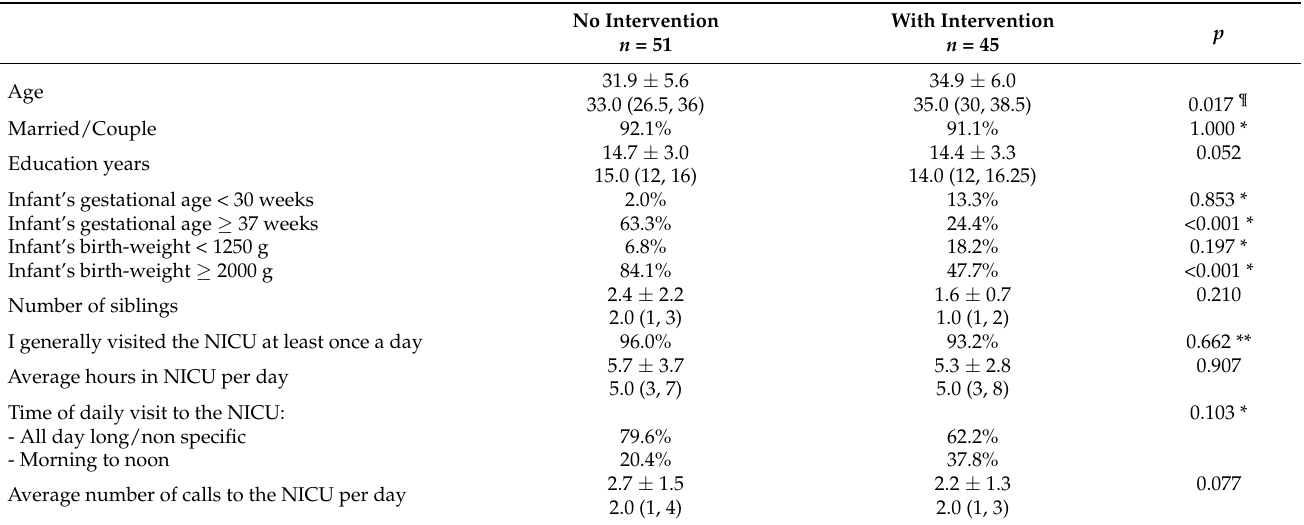
Table 1. Parent and infant characteristics in the study and control groups (with and without the new electronic